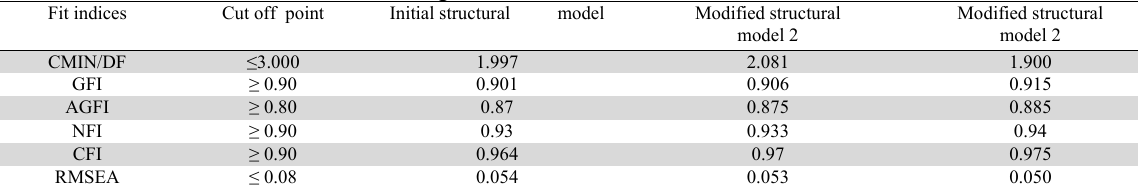
Fit Indices of Structural Model: Internet Banking